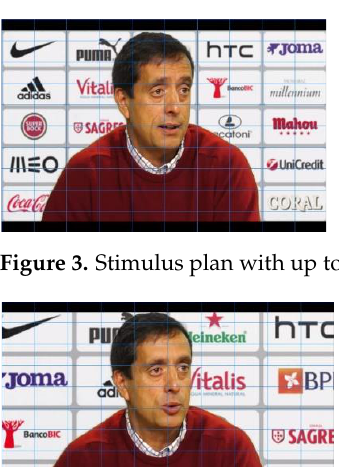
Figure 2. Stimulus plan with up to 50 logos.